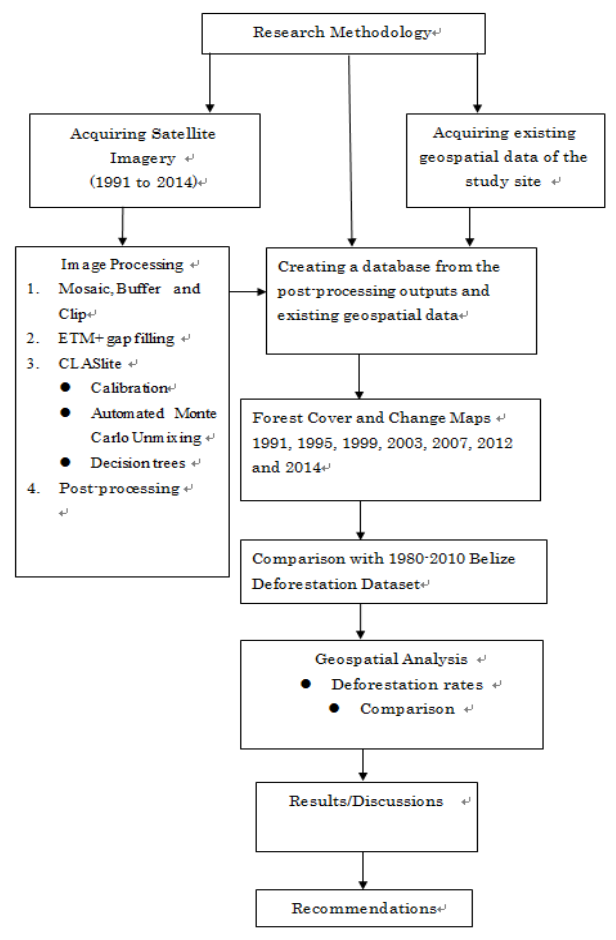
Figure 2. Flow diagram depicts the preparation and analysis of geospatial data in the forest cover and change